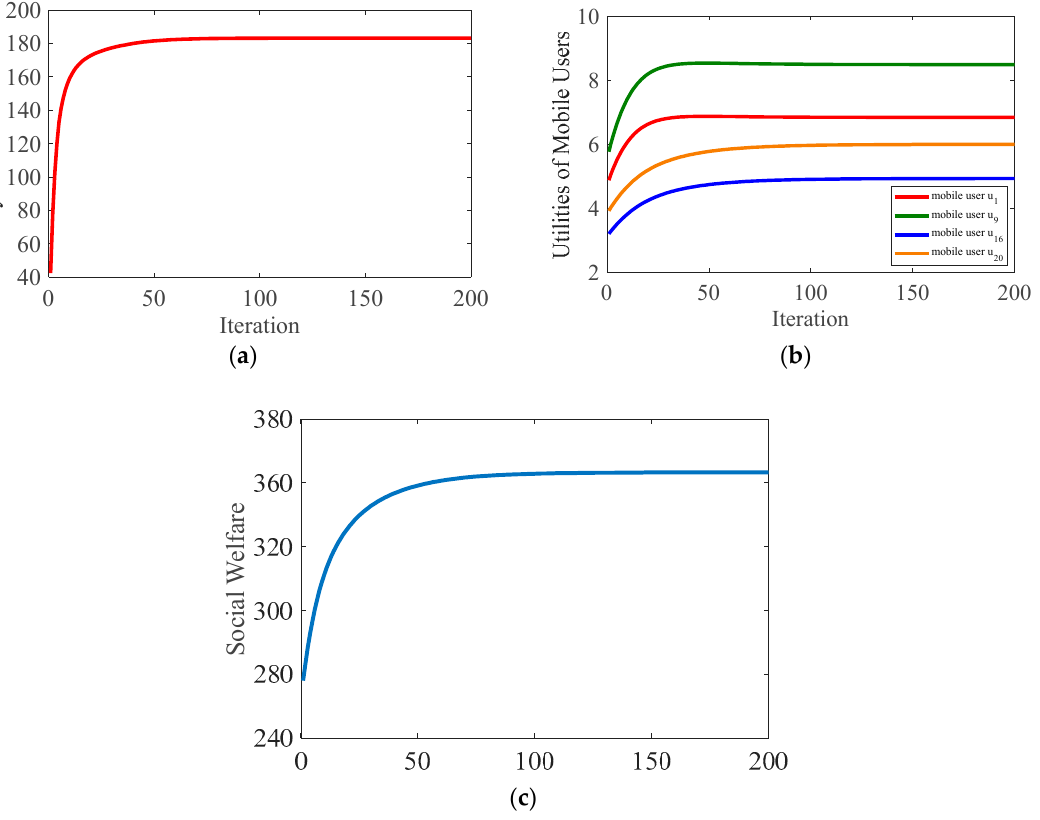
Figure 3. Utility changes with the iteration process in our proposed algorithm: ( a ) utility of the crowdsourcer; ( b ) utility of mobile user u 1 , u 9 , u 16 , and u 20 ; and ( c ) social